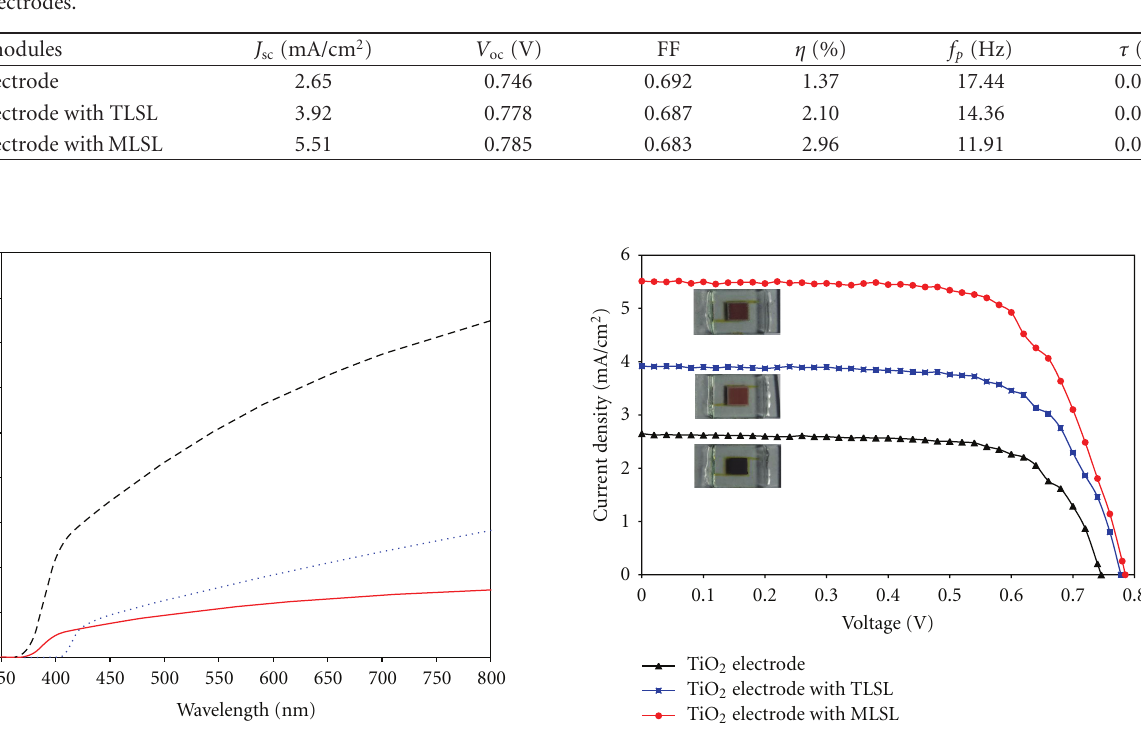
Figure 5: Photocurrent density-voltage curves for DSSCs based on di ff erent photo